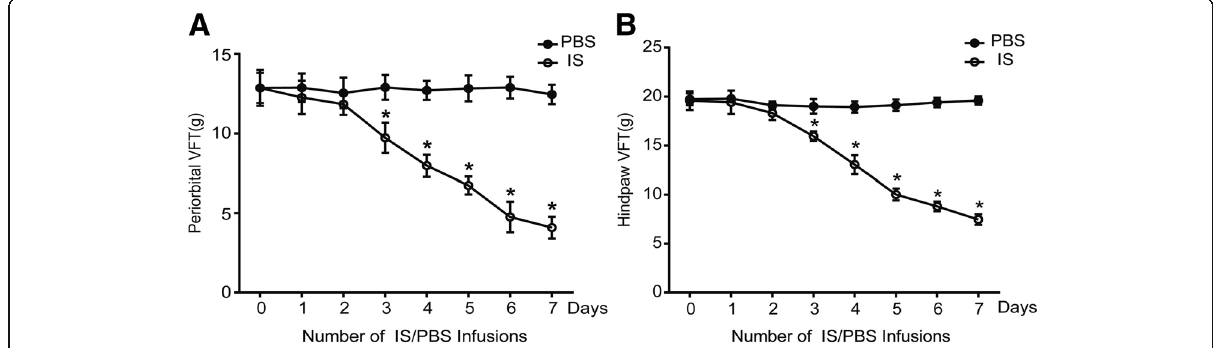
Fig. 1 Development of mechanical allodynia in rats. a The pain thresholds of the periorbital region were significantly decreased after three days of IS infusions compared with those detected after three days of PBS infusions. b A significant decrease in the hindpaw thresholds was observed after three days of IS infusions compared with those detected after three days of PBS infusions ( n = 10 each group, * P <